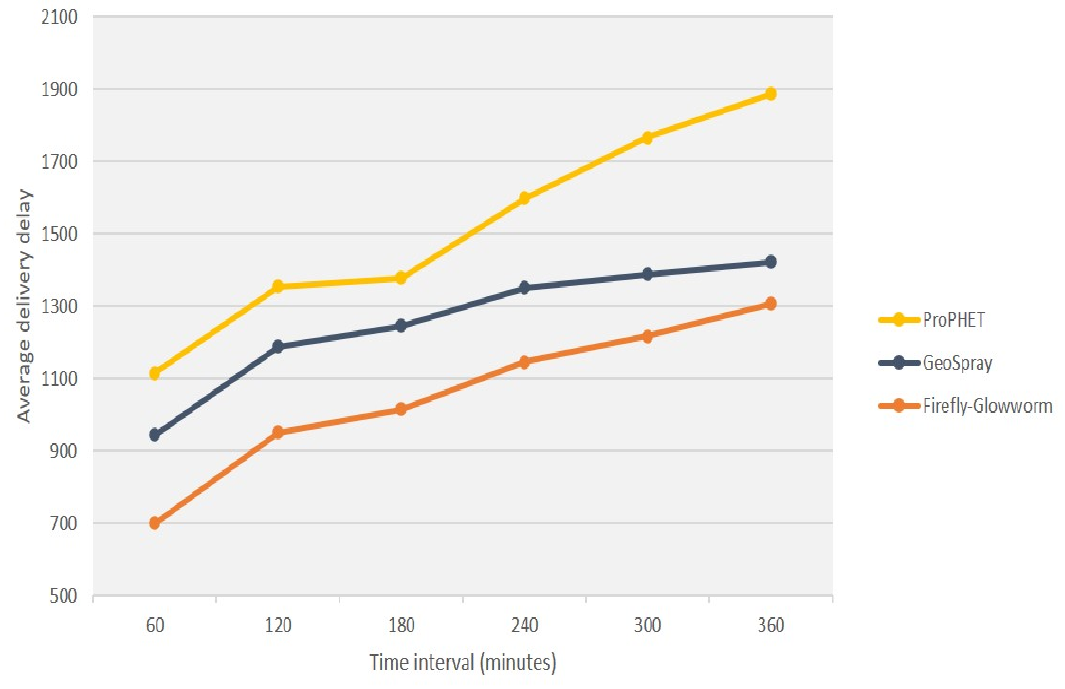
Figure 5. Average delivery Figure 5. Average Delivery Delay.